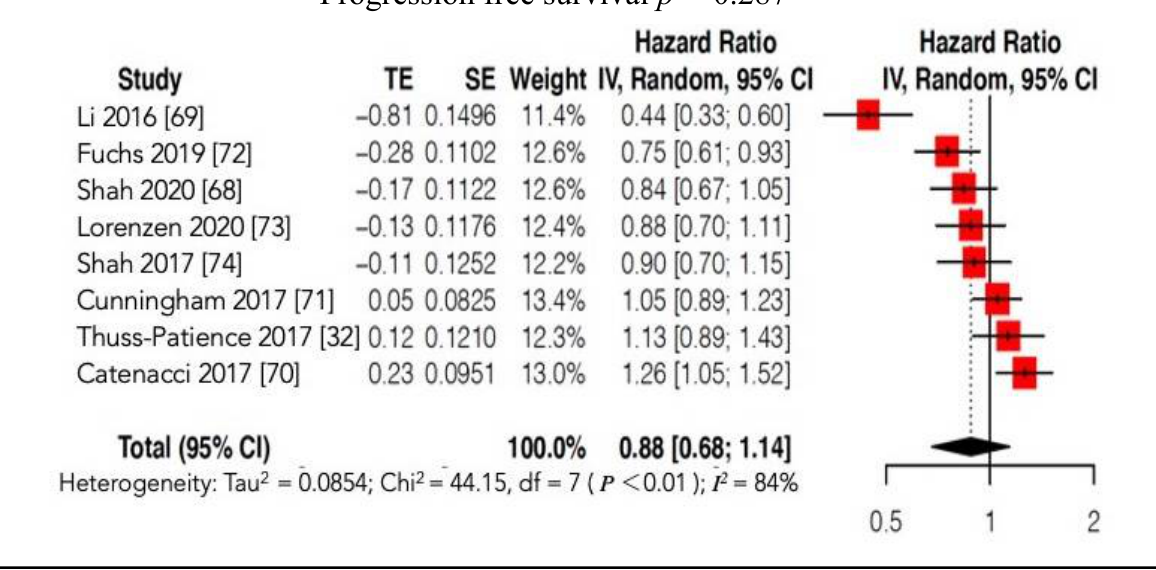
Figure 5. Forest plot of comparison: molecular-targeted therapy alone/plus chemotherapy versus chemotherapy alone/placebo. Main analyses; outcome: progression free